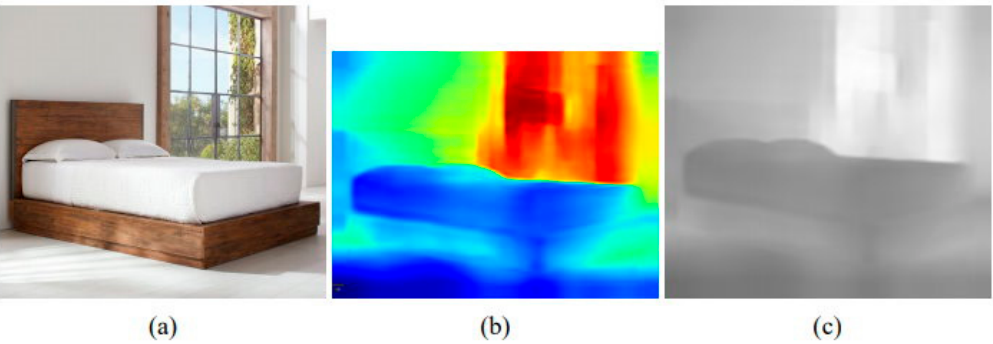
Figure 2. Upscaling the depth map: ( a ) the input image (558 × 501); ( b ) the extended depth map (157 × 119); and ( c ) the upscaled depth map (558 ×